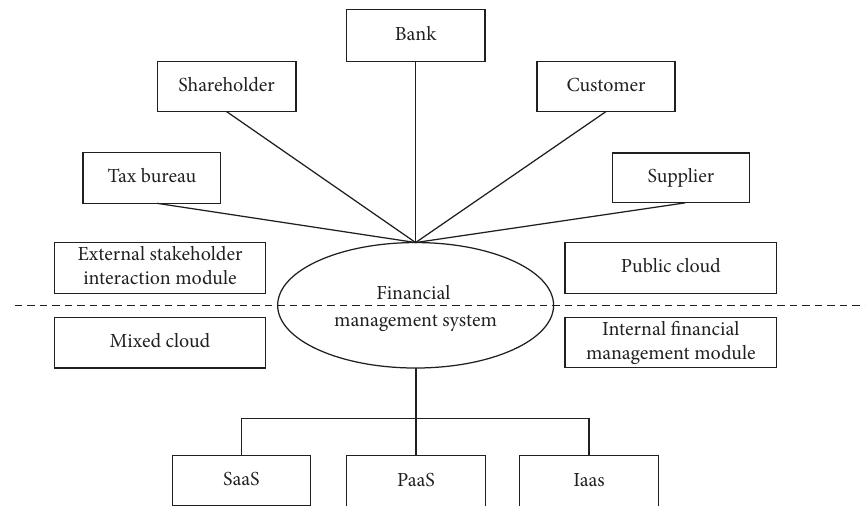
Figure 1: Supply chain informatization construction